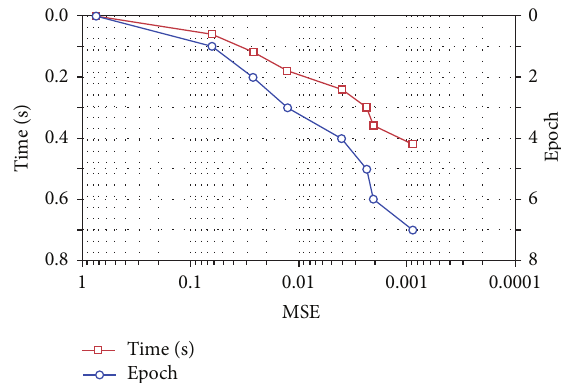
Figure 9: Time and epochs required by the ANN model to reach desired